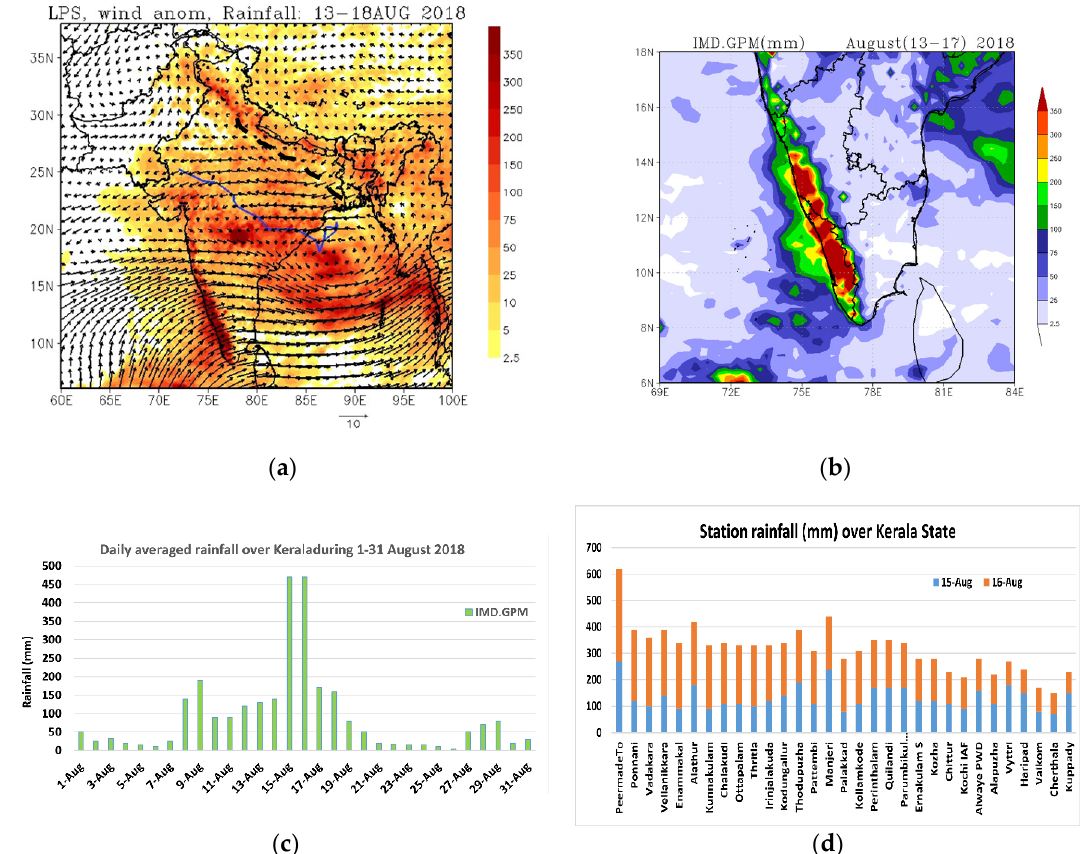
Figure 1. ( a ) Accumulated rainfall (mm, shaded), wind anomaly (850 mb), and low-pressure system (LPS) track (blue line) over India during 13–18 August 2018, where the dark dashed line represents the mean positions of monsoon depressions. ( b ) Kerala state derived from Indian Meteorological Society (IMD) + Global Precipitation Measurement (GPM) merged products at a 25 km resolution for 13–17 August 2018. ( c ) Daily area-averaged rainfall (mm) over the Kerala state (8° N–13° N and 74° E–78° E) during August 2018. ( d ) Different station rainfall over Kerala derived from an IMD rain gauge during 03 UTC 15–16 August 2018 (stations with <7 cm of rainfall are ignored). In all the figures “Aug” is used as the short form of “August”.